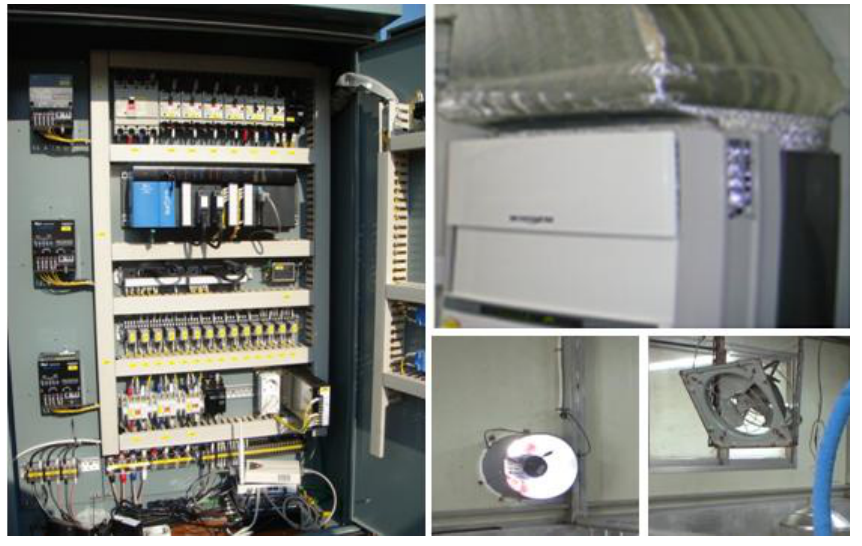
Figure 14. Digital Controller (PLC) and Hog Farm Facilities.